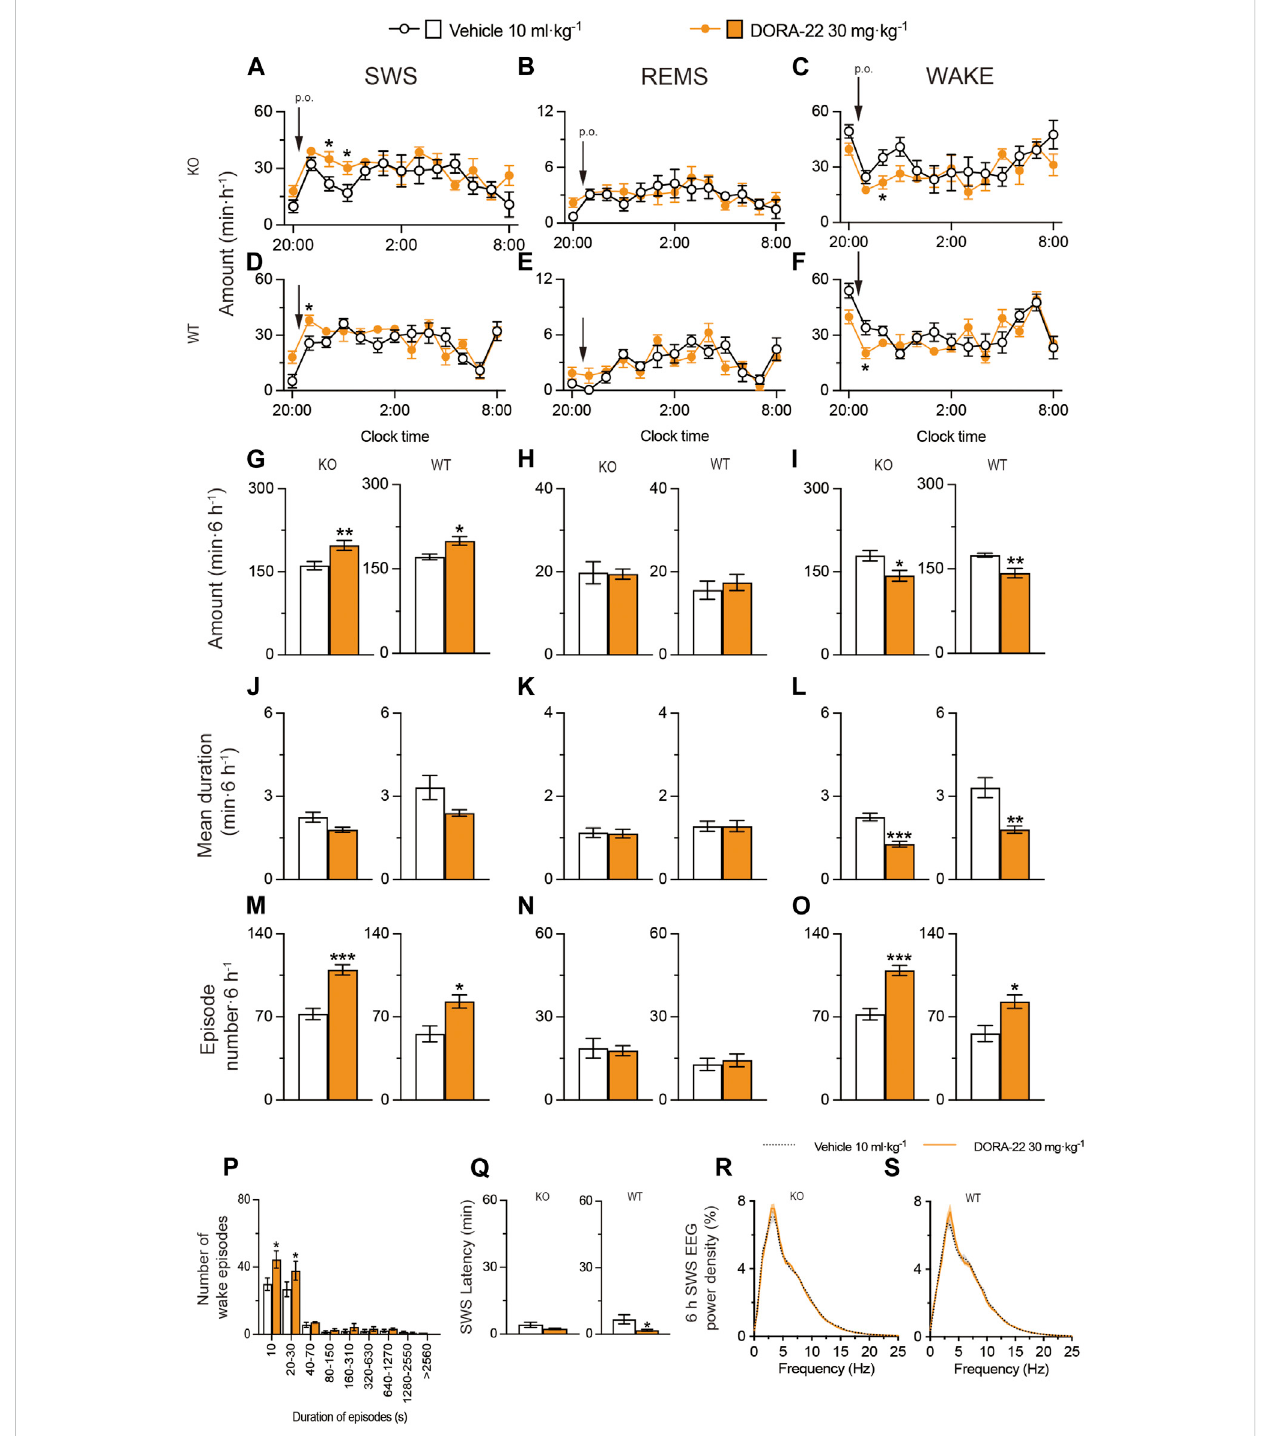
FIGURE 8 Oral administration of DORA-22 induces sleep in a mouse model of schizophrenia. (A – O) Time course (A – F) , total amount (G – I) , mean duration (J – L) , andepisode number (M – O) of SWS,REMS, andwakefulnessin MAP6 (STOP) knockout (KO) andwild-type(WT) mice after administeringvehicleor DORA-22. (P) Wake episode spectrum in MAP6 (STOP) KO mice. (Q) Latency to sleep onset in MAP6 (STOP) KO and WT mice after administering vehicle orDORA-22. (R,S) EEGpowerdensityofSWSfor6 hafteradministeringvehicleorDORA-22intoMAP6(STOP)KO (Q) andWT (R) mice.Data(n=6/ group) are presented as mean ± SEM. Signi fi cance levels are indicated as * p < 0.05, ** p < 0.01, and *** p <